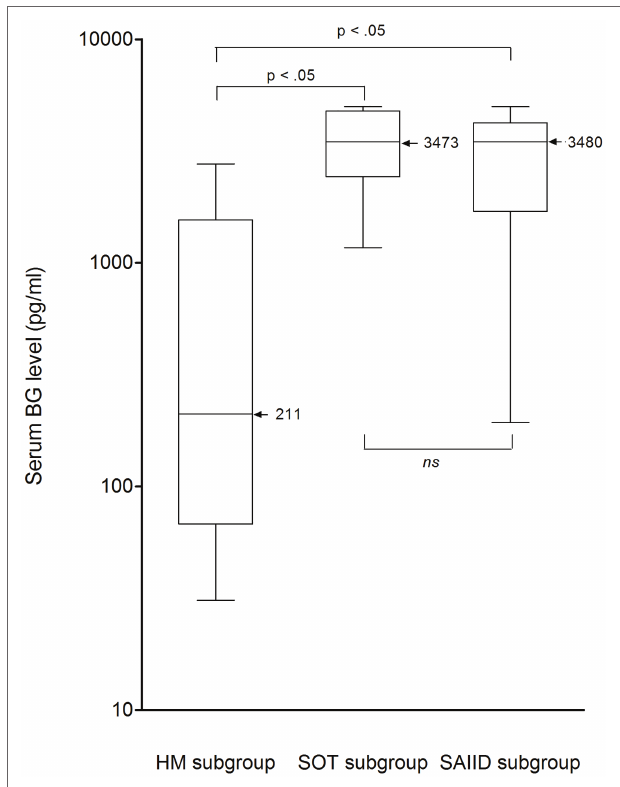
FIGURE 2 | Serum BG levels (pg/ml) in patients with Pneumocystis pneumonia from HM, SOT, and SAIID subgroups. Black horizontal bars, median values. The median value for HM patients was 211 pg/ml (range, 31–2,771; interquartile range, 1,489 pg/ml). The median value for SOT patients was 3,473 pg/ml (range, 1,170–5,000; interquartile range, 2,013 pg/ ml). The median value for SAIID patients was 3,480 pg/ml (range, 610–5,000; interquartile range, 2,515 pg/ml). Median BG level was significantly lower in the HM subgroup than in the SOT and SAIID subgroups (Bonferroni’s test, p < 0.05). No significant difference was observed between SOT patients and SAIID patients. BG, (1,3)- β -D-glucan; HM, hematological malignancy; ns, non-significant; SAIID, systemic autoimmune and inflammatory disorder; and SOT, solid organ transplant.